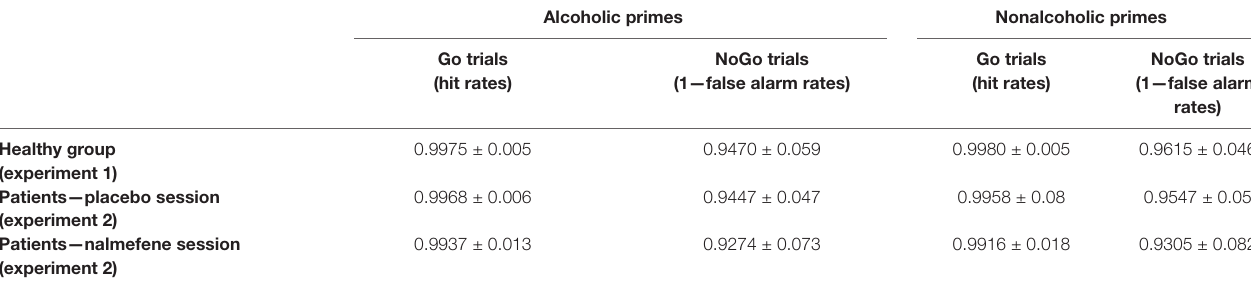
TABLE 2 | Behavioral accuracy (proportion of correct responses) in the four trial types from both experiments (mean ± standard deviations).